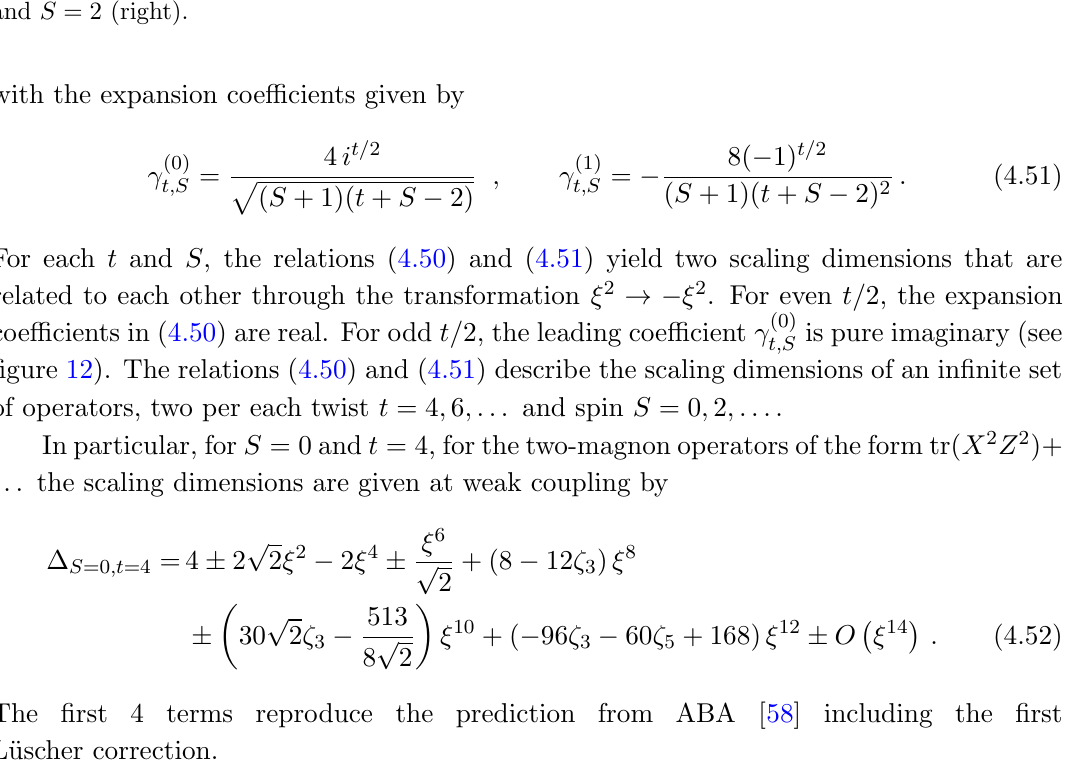
Figure 12 . Spectrum of the scaling dimensions ∆ 2 ( ξ ) of the two-magnon operators for S = 0 (left) and S = 2